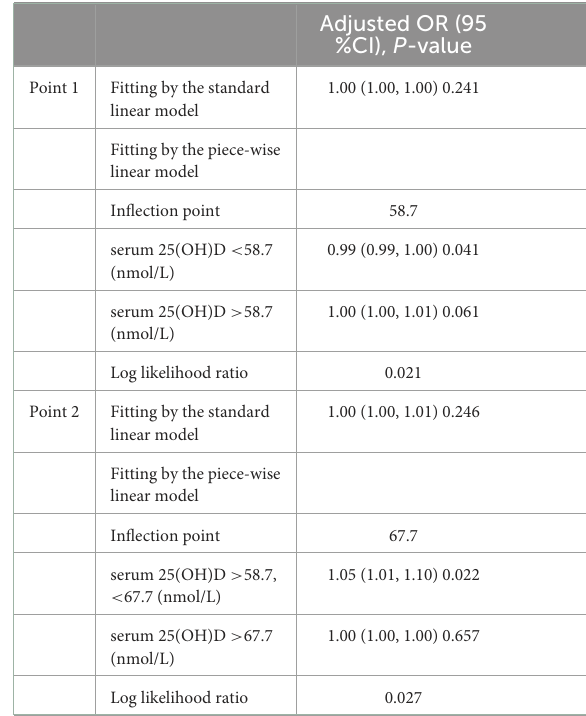
TABLE 4 Inflection point analysis of serum 25(OH)D based on piece-wise linear regression